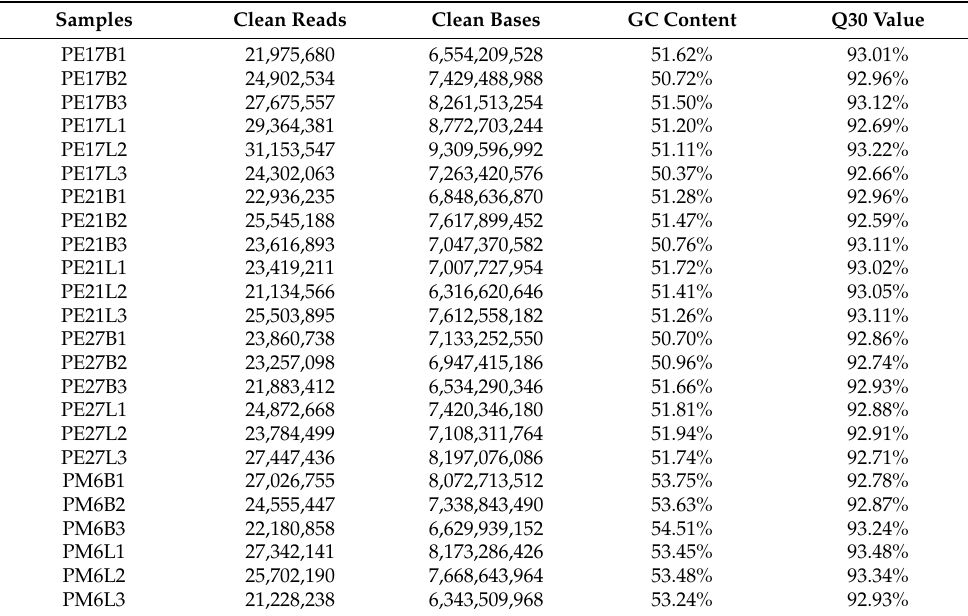
Table 2. RNA-Seq data from breast and leg muscle of Pekin duck.